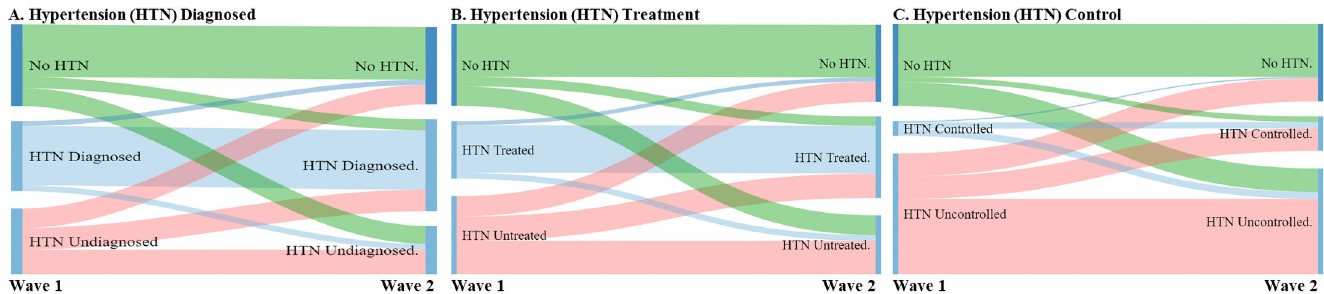
Fig 2. Transitions between hypertension states. Notes . Each figure in the top panel gives a visual representation of the data presented in the respective transition matrix table below it. The sample size is 945 for each panel.